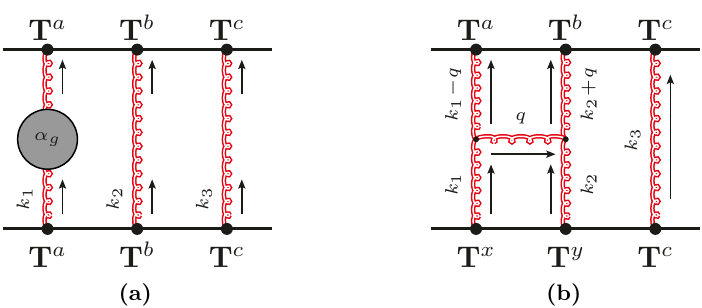
Figure 3. Diagrammatic representation of the first term (a) and of the second term (b) in eq. (4.8).